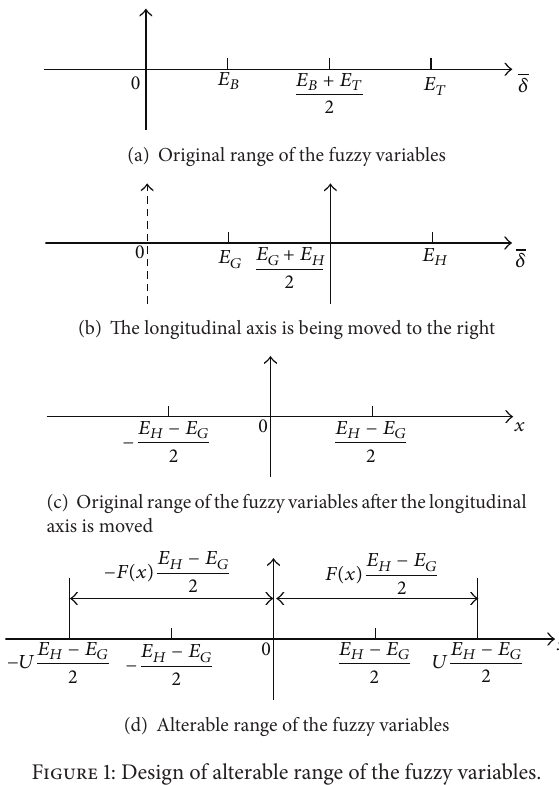
Figure 1: Design of alterable range of the fuzzy